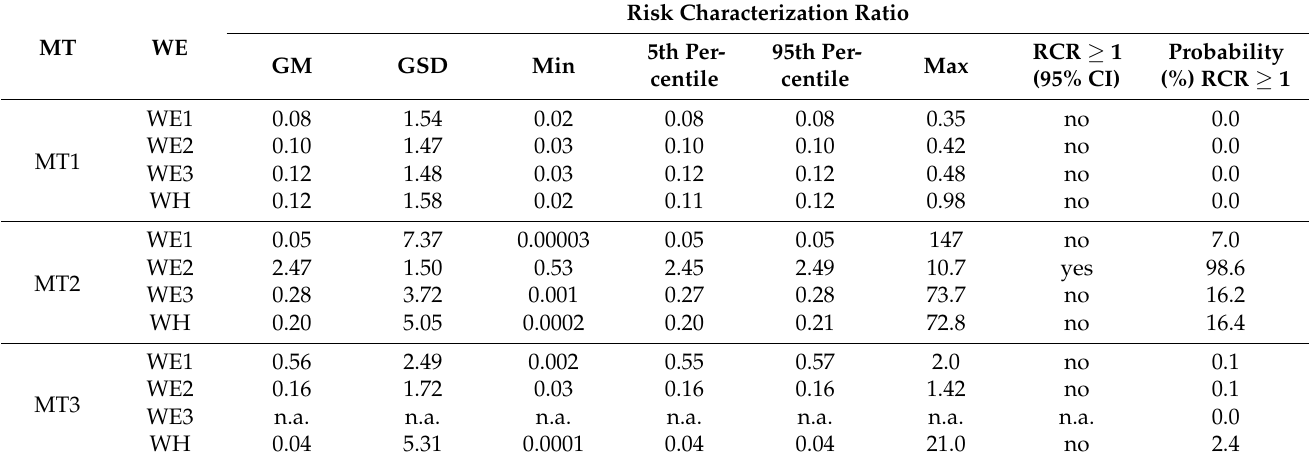
Table 4. RCR distributions for WE1-3 and WH (10,000 Monte Carlo simulations). RCR distributions were calculated considering mass concentrations [ µ g/m 3 ] as metrics for exposure and BMC h distributions. The data are presented as geometric mean (GM), geometric standard deviation (GSD), minimum and maximum values (min, max) and lower and upper limits of the confidence interval of the mean (95% CI). Note: n.a. = not